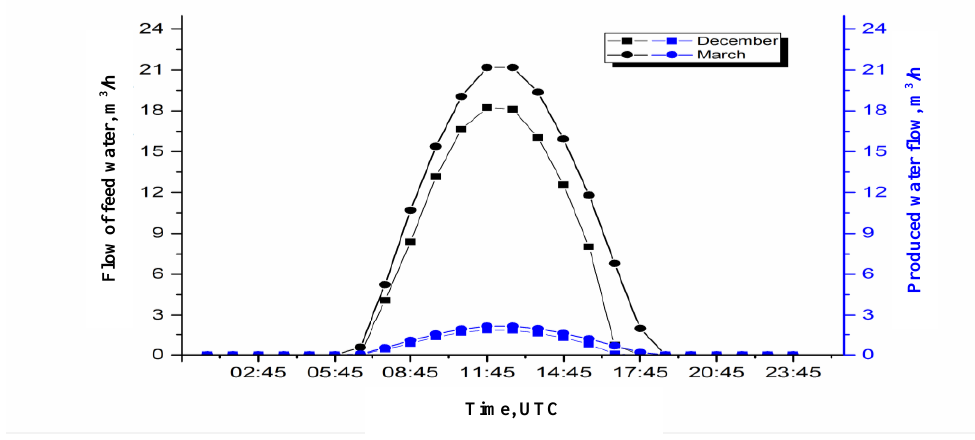
Fig. 9. Flow rate of feed water and produced water flow for a C a = 2 g/l and a conversion rate y = 10 % in